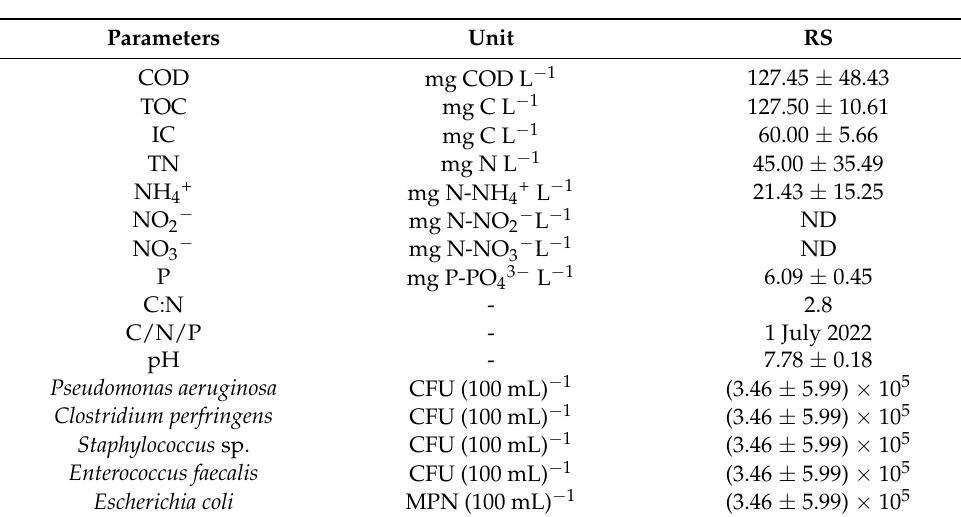
Figure 1. Schematic diagrams of the three HRAPs (R1, R2, and R3) for the removal of pathogens and nutrients from primary domestic wastewater. Table 1. Physical–chemical and biological characterization of RS during the